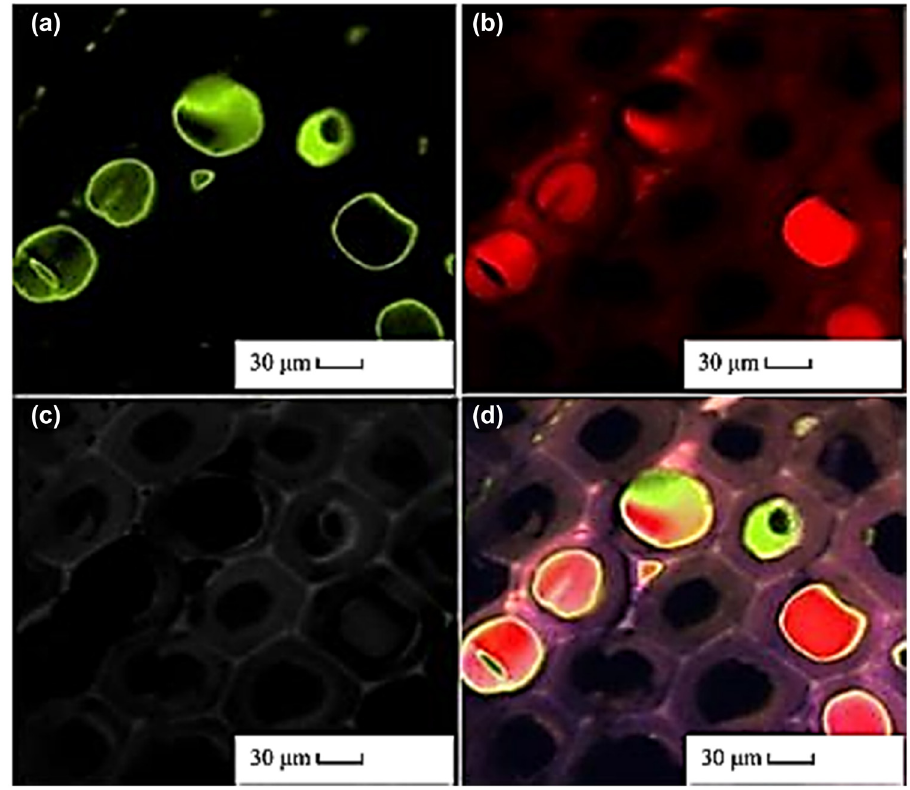
Figure 5: The scanning microscope image of wood treated with maleic anhydride: ( a ) resin I with a better degree of polymerization in the fi rst channel ( 650 – 700 nm ) ; ( b ) resin II with a lower degree of polymerization in the second channel ( 700 – 750 nm ) ; ( c ) anatomical structure of wood; and ( d ) reconstruction images obtained from all channels [ 53 ]